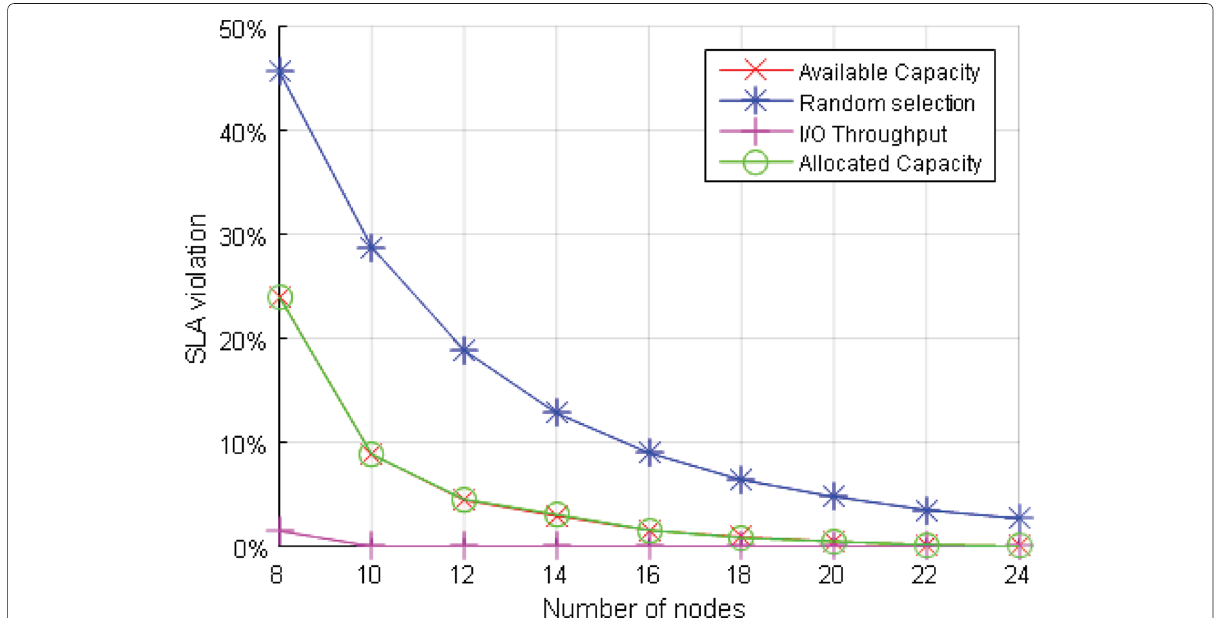
Fig. 6 Violation rates of different weight sorting strategies with different counts of nodes